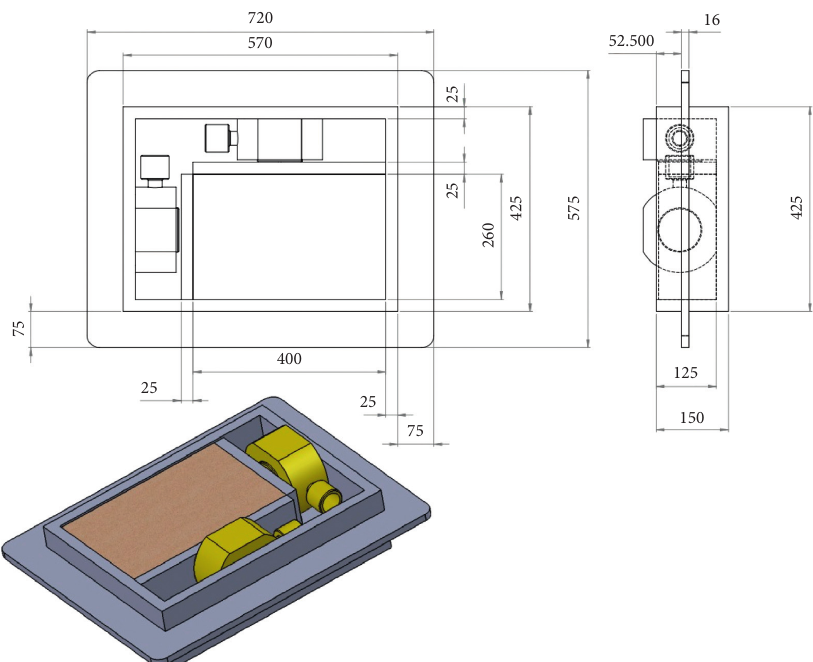
Figure 4: Steel box designed for applying confining stresses (all dimensions in